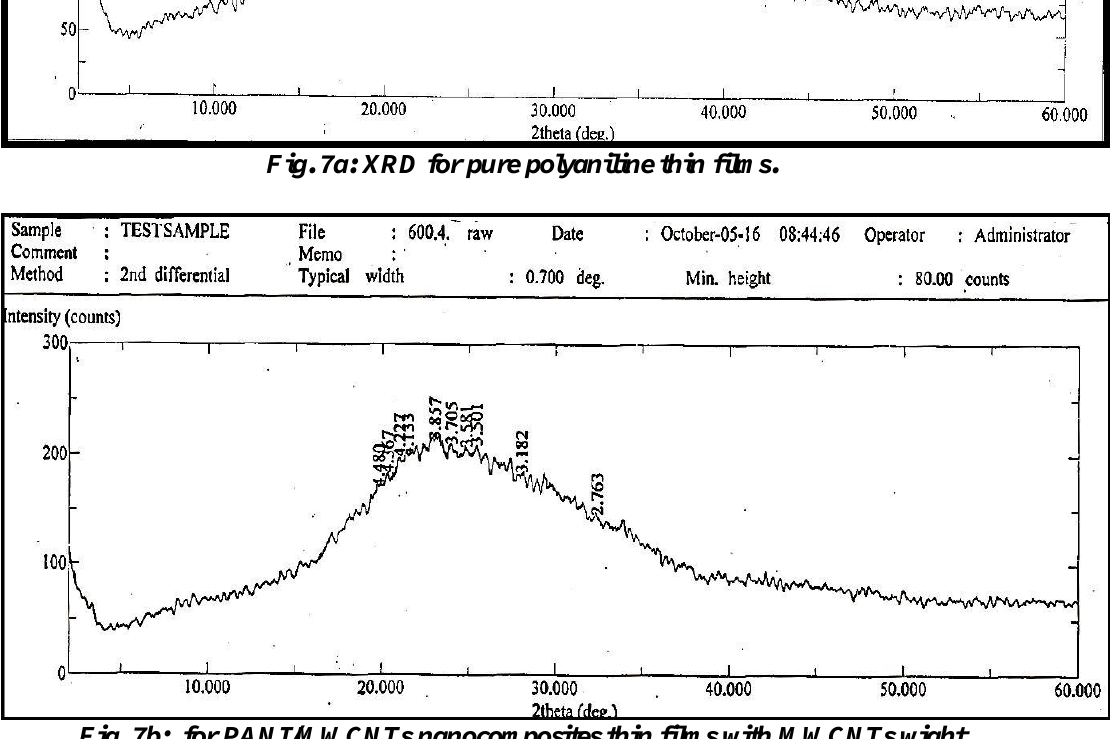
Fig. 7b: for PANI/MWCNTs nanocomposites thin films with MWCNTs wight concentration